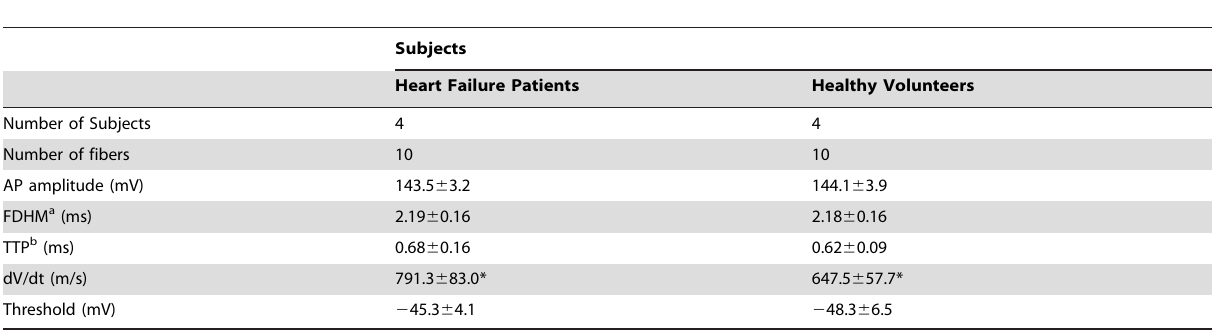
Table 2. Properties of action potentials recorded in fibers from healthy volunteers and HF